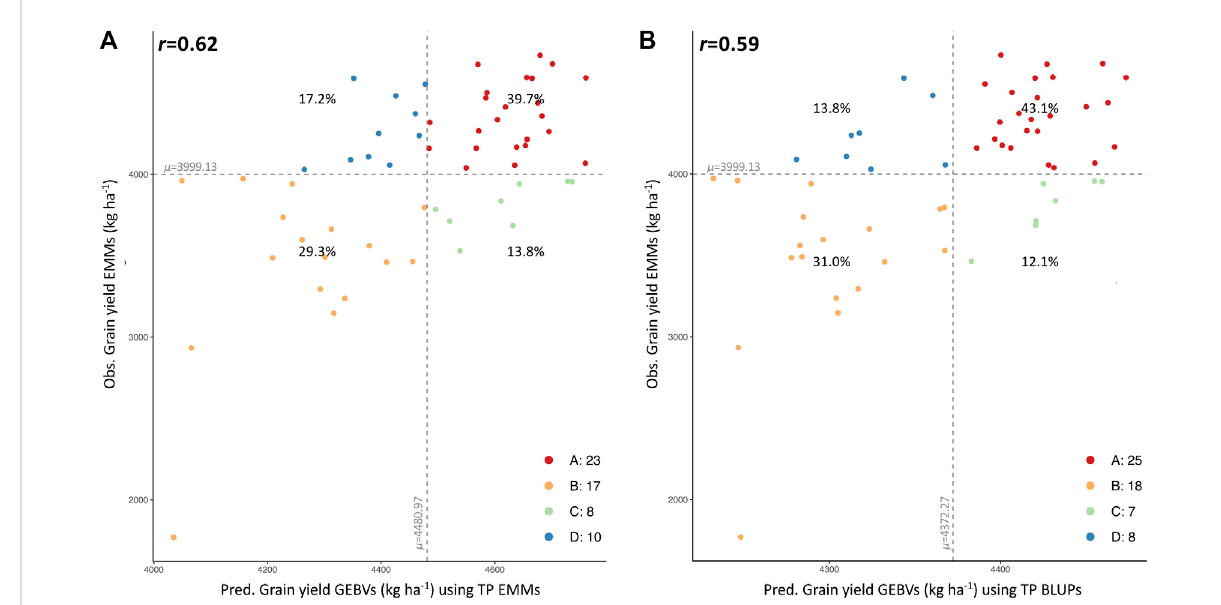
FIGURE 3 Four-quadrantplotsshowingthecorrelationbetweenpredicted(GEBVs,x-axis)andobservedyield(EMMs,y-axis)for58SCadvancedbreeding linesusingthecombinedTPdata(SetAll_TP).CorrelationbetweenobservedandpredictedvaluesforYLDusingTPEMMs (A) andTPBLUPs (B) .Mean of observed and predicted values is dividing the plot into 4 quadrants, A (upper-right section in red), B (lower-left section yellow), C (lower-right section in green) and D (upper-left section in blue). Percentage (%) of total lines classi fi ed in each quadrant is